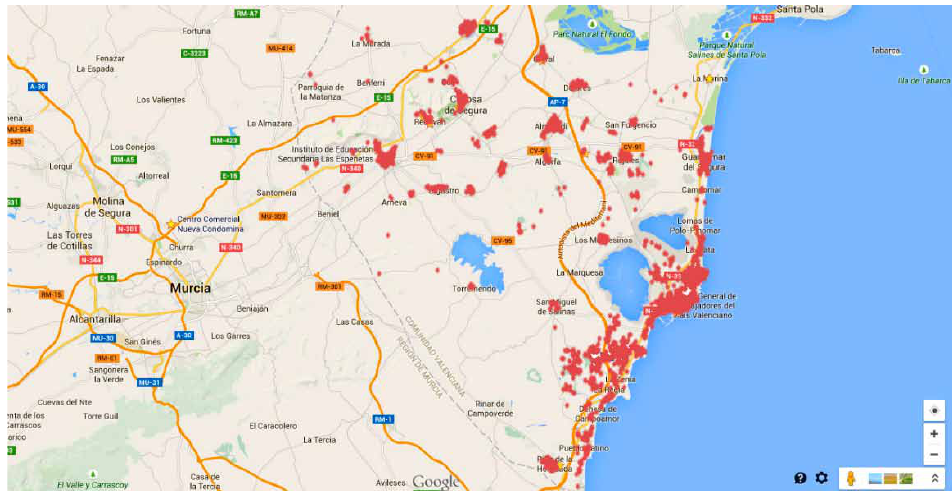
Fig. 1. Database spatial distribution in Vega Baja County (Red dots represent the houses